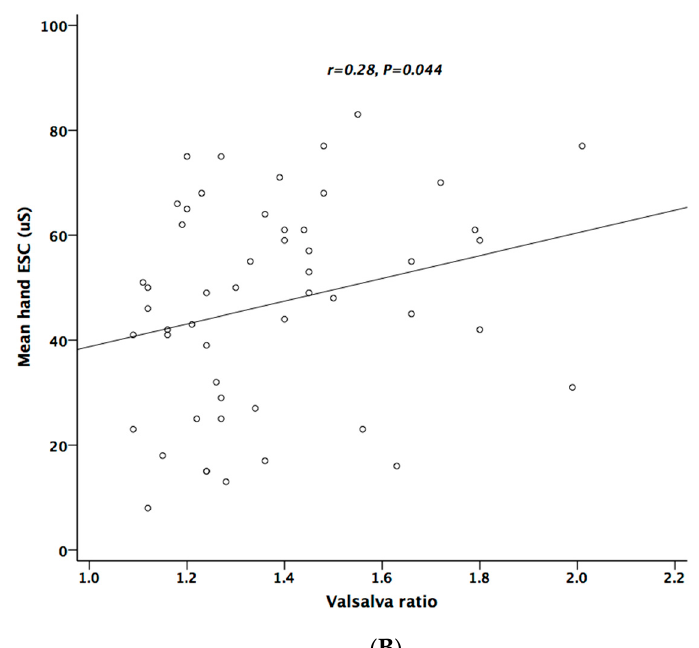
Figure 1. The relationship between electrochemical skin conductance (ESC) of hand and UPDRS ( A ), and between hand ESC and Valsalva ratio ( B ).